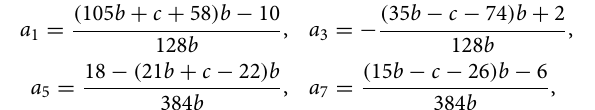
π , π , with 2 2 − 2, c 5 (dotted). The three pulses vanish at the = − (cid:30) (cid:31) � < 2 for full | |